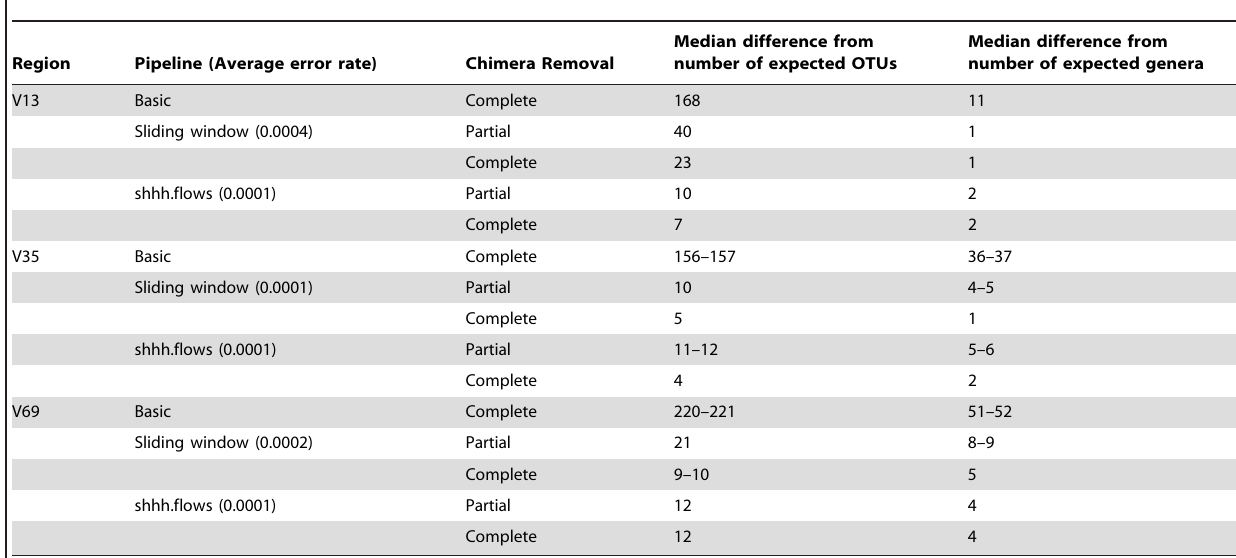
Table 2. Median number of spurious OTUs and genera identified in mock community sequence collections after removing chimeras identified using Uchime and removing all true chimeras within the two pipelines.